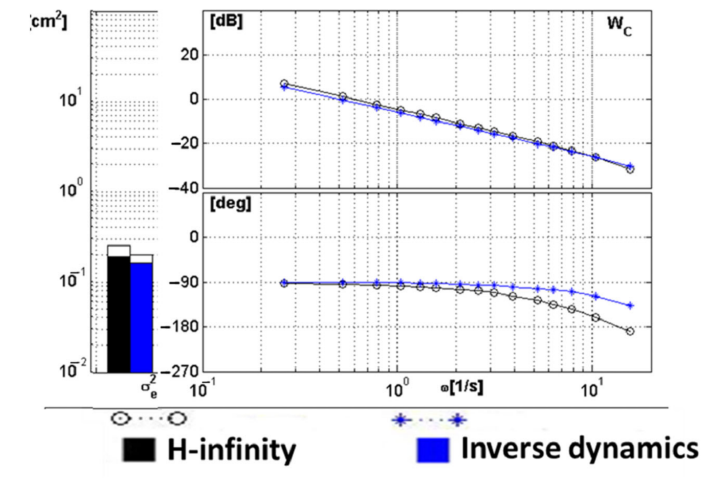
Figure 10. Inverse dynamics vs. H-infinity with actuator constraints and high gain.